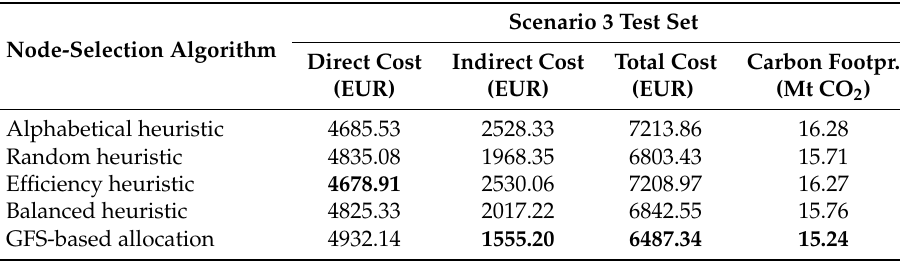
Table 5. Experiment results for the test set of Scenario 3.